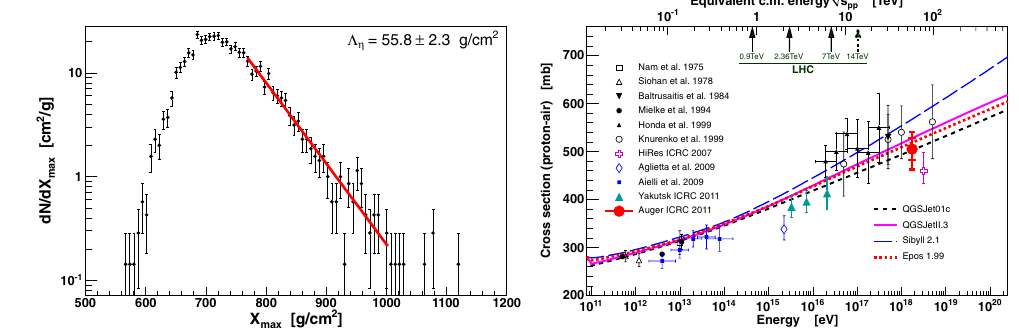
Figure 1. Left panel : unbinned likelihood fit to obtain (cid:1) (cid:1) (thick line). The X max -distribution is unbiased by the fiducial geometry selection applied in the range of the fit. Right panel : resulting (cid:2) prod p − measurements (see [7–14] for references) and model predictions. The inner error bars are statistical, while the outer are the sum of statistic and systematic uncertainties in